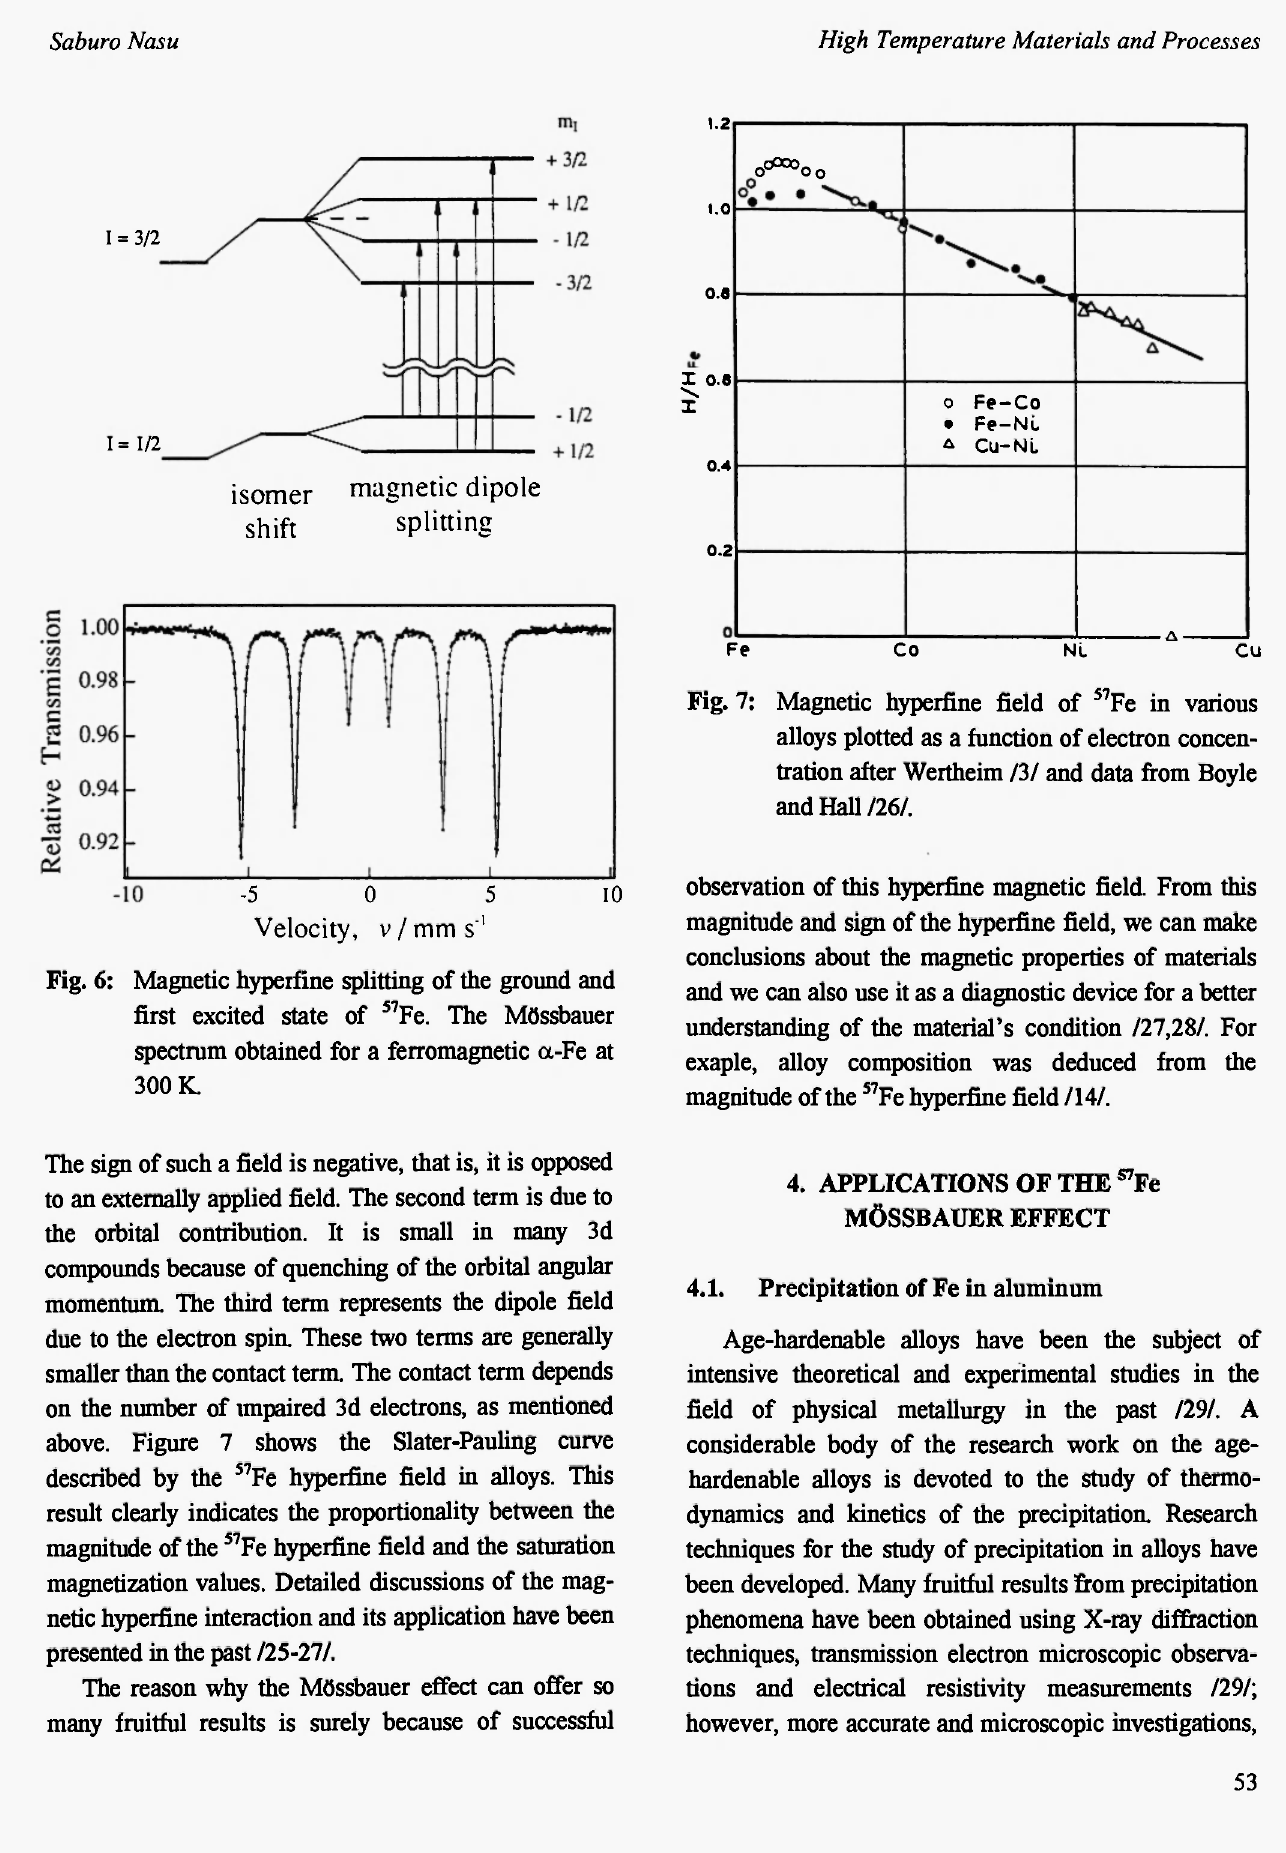
Fig. 7: Magnetic hyperfine field of 57 Fe in various alloys plotted as a function of electron concen- tration after Wertheim /3/ and data from Boyle and